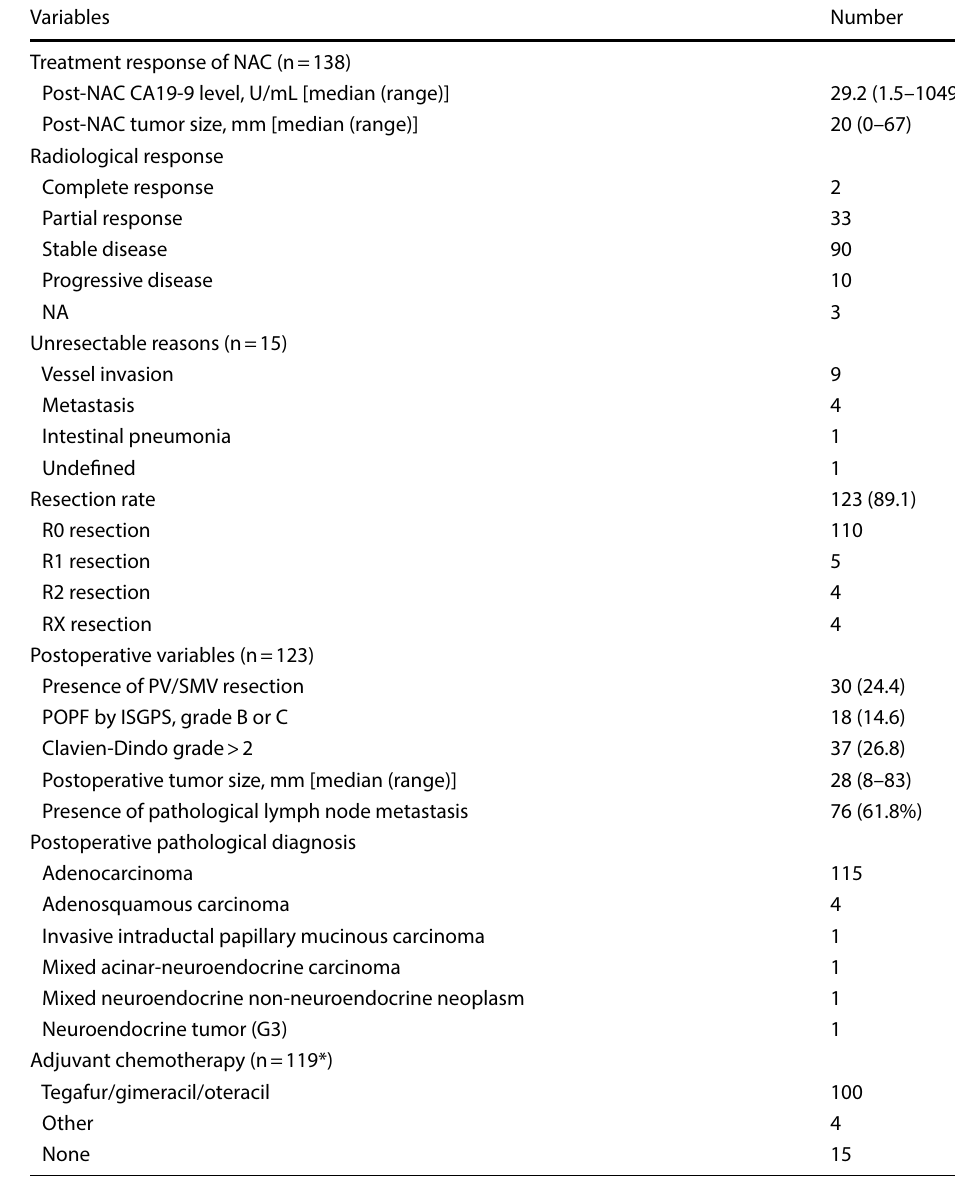
Table 2 Post- neoadjuvant chemotherapy patient characteristics and clinicopathological characteristics of the